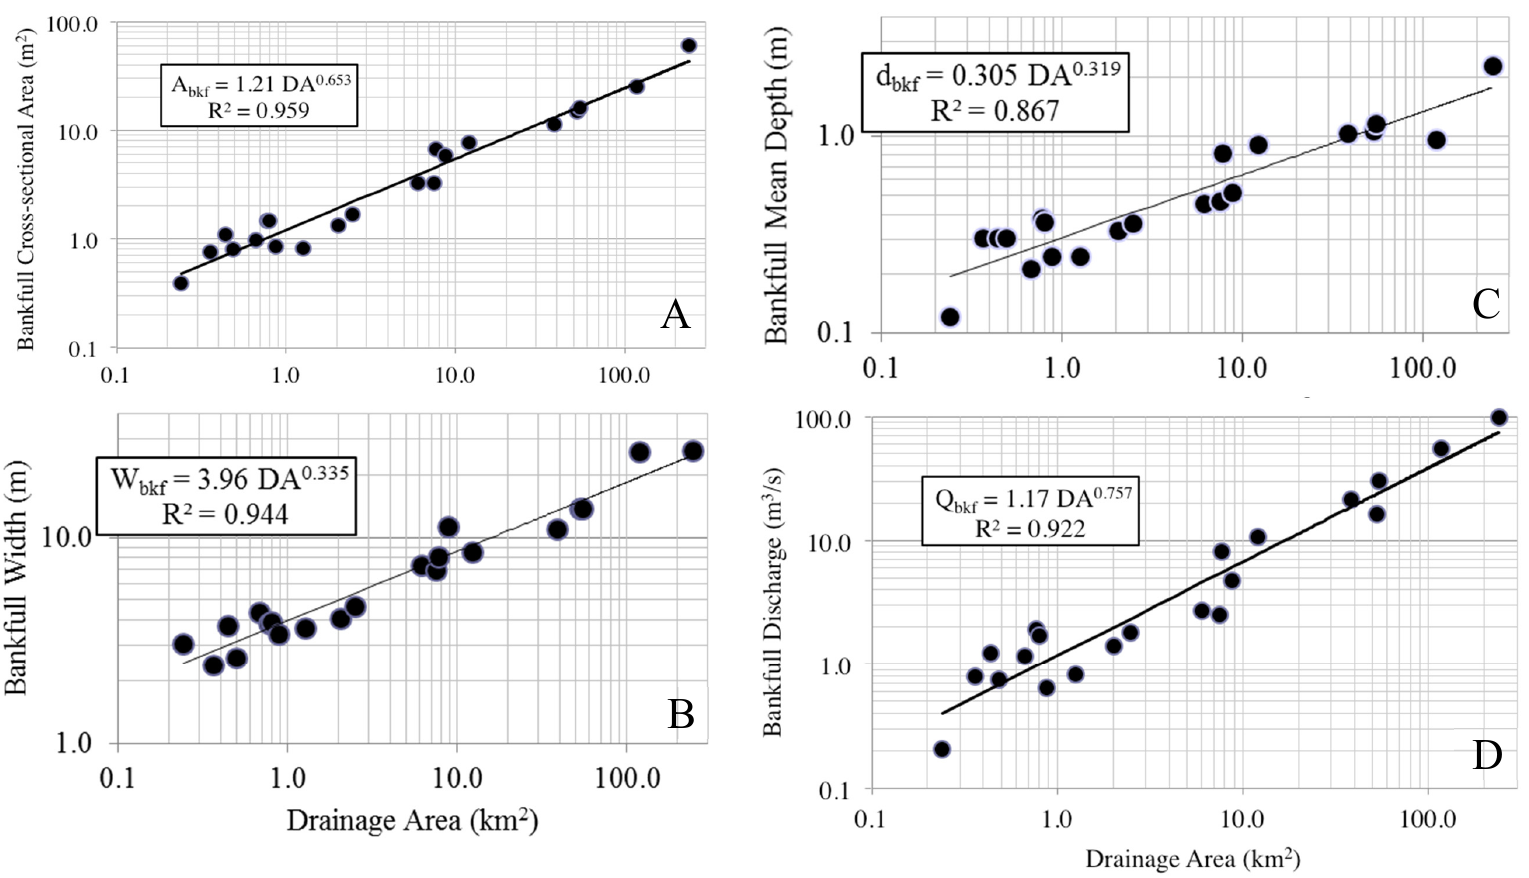
Figure 2. Regional geomorphic curves for Alabama Piedmont reference streams. All channel dimension variables are related to drainage area by the power model y = ax b , where y is channel dimension measure and x is drainage area, a is slope and b is model parameter. ( A ) bankfull cross-sectional area, ( B ) bankfull cross-sectional width, ( C ) bankfull cross-sectional depth, ( D ) bankfull discharge.